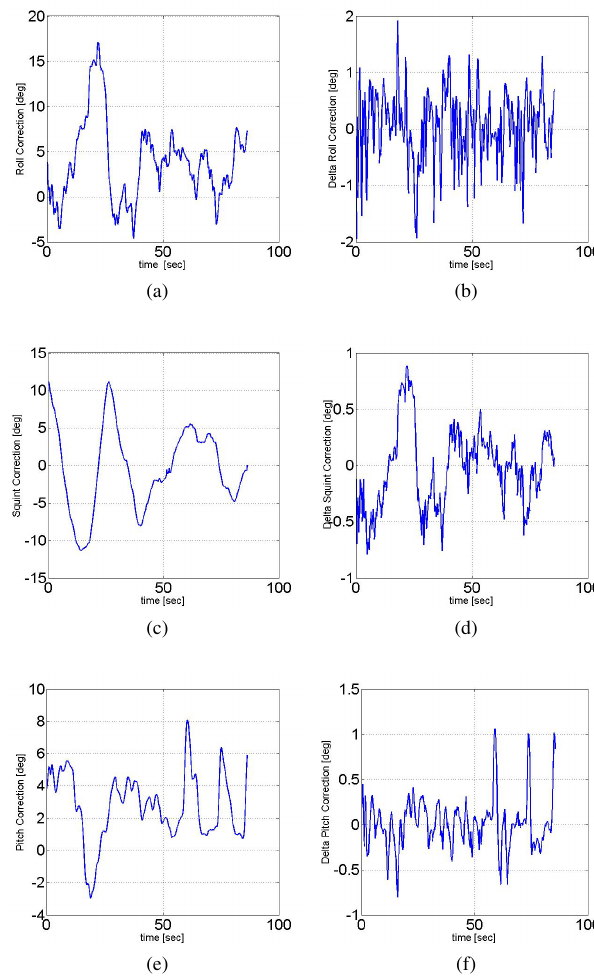
Figure 6: Stabilization Parameters for roll (a,b), squint (c,d) and pitch (e,f) showing experimental data. Total rate of correction over full trajectory on the left side - total compensation rate on the right